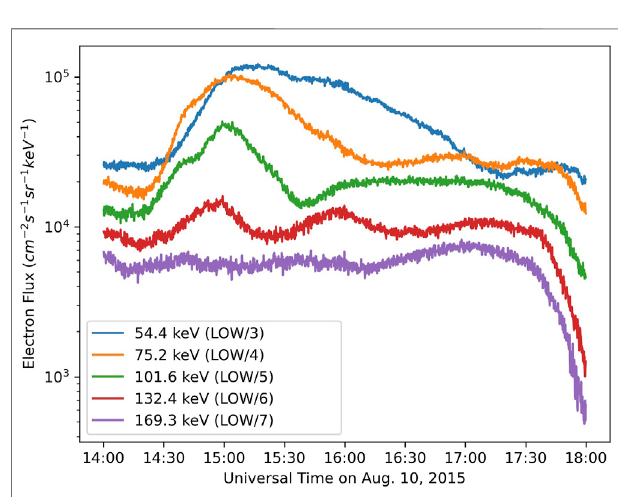
FIGURE3| Electronintensitynearthelosscone( α (cid:1) 24.5 ° )in fi veenergy channels as measured by the RBSP-B MagEIS